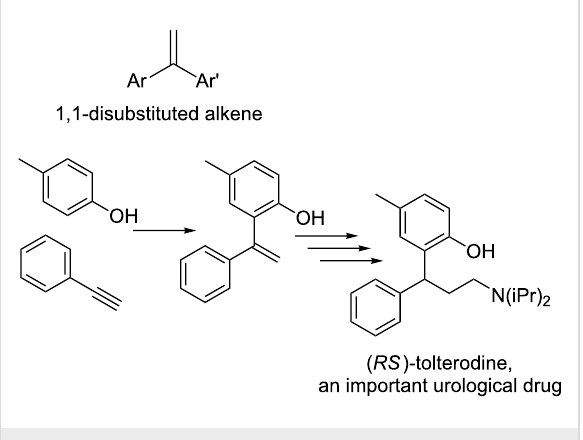
Figure 1: ( RS )-Tolterodine, an important urological